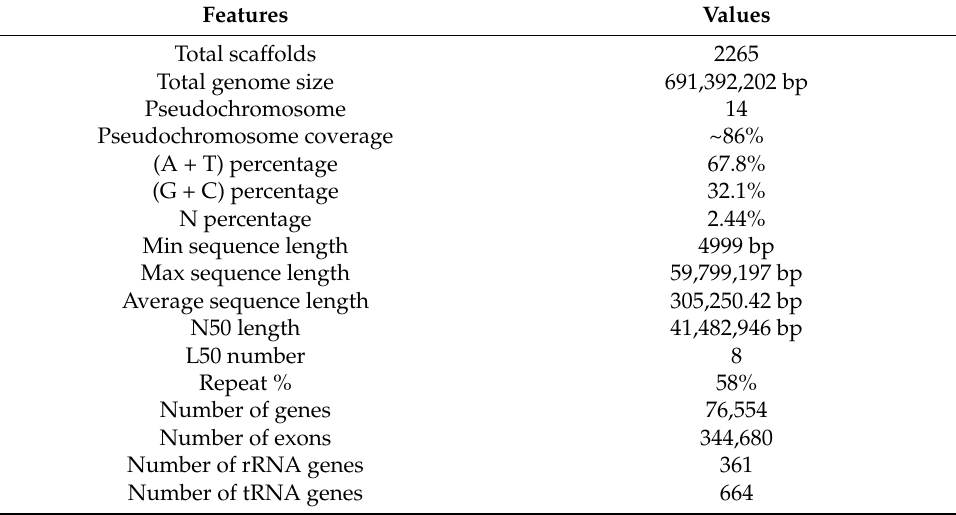
Table 1. P. cineraria genome assembly